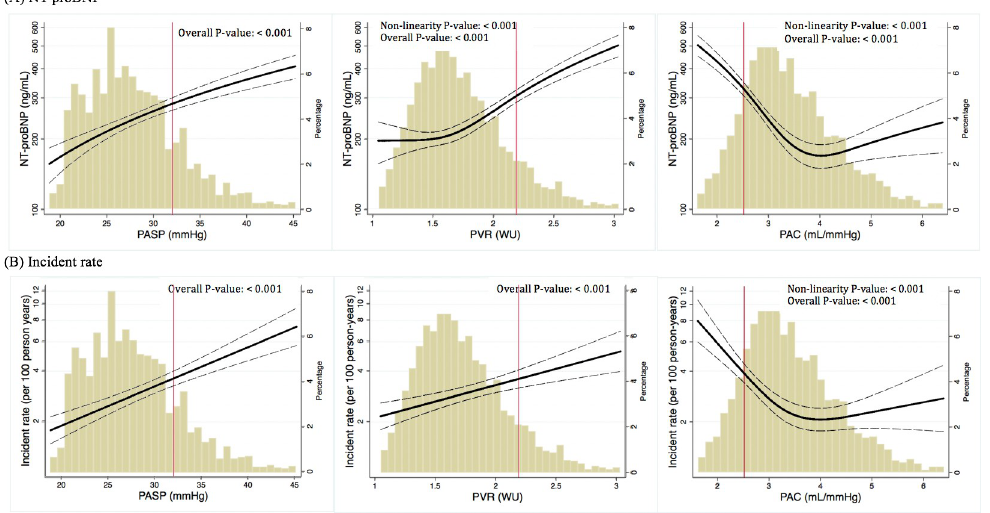
Fig 3. Association of pulmonary hemodynamic measures with (A) plasma NT-proBNP concentrations and (B) incident HF or death post visit 5. Histogram shows the distribution of the primary hemodynamic variable in the study sample. Black dotted line represents 95% confidence interval. Red line indicates the ARIC-based reference value for abnormal for that pulmonary vasculature measure (see text for details). p -Values are derived from cubic spline model adjusted for age, sex, race, visit center, and LV measures (LVEF, LAVi, LVMi, and septal E/E’). ARIC, Atherosclerosis Risk in Communities; HF, heart failure; LAVi, left atrial volume index; LV, left ventricular; LVEF, LV ejection fraction; LVMi, LV mass index; NT- proBNP, N-terminal prohormone brain natriuretic peptide; PAC, pulmonary arterial compliance; PASP, pulmonary artery systolic pressure; PVR, pulmonary vascular resistance; WU, Wood unit.